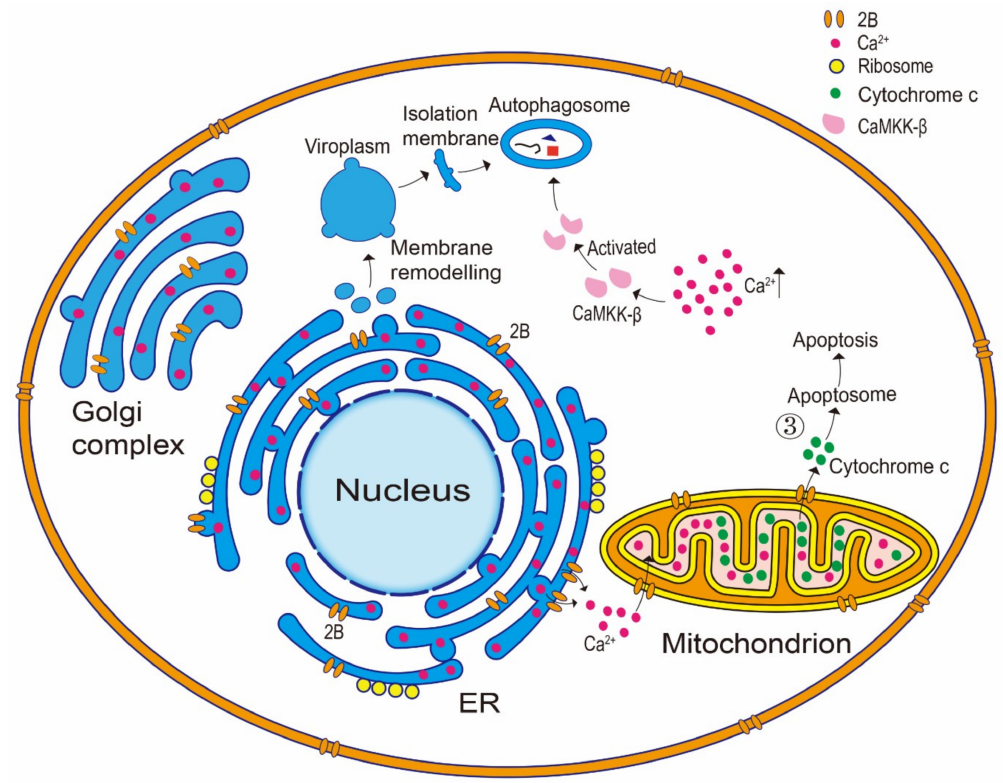
Figure 2. 2B protein regulates autophagy and apoptosis. The 2B protein induces target